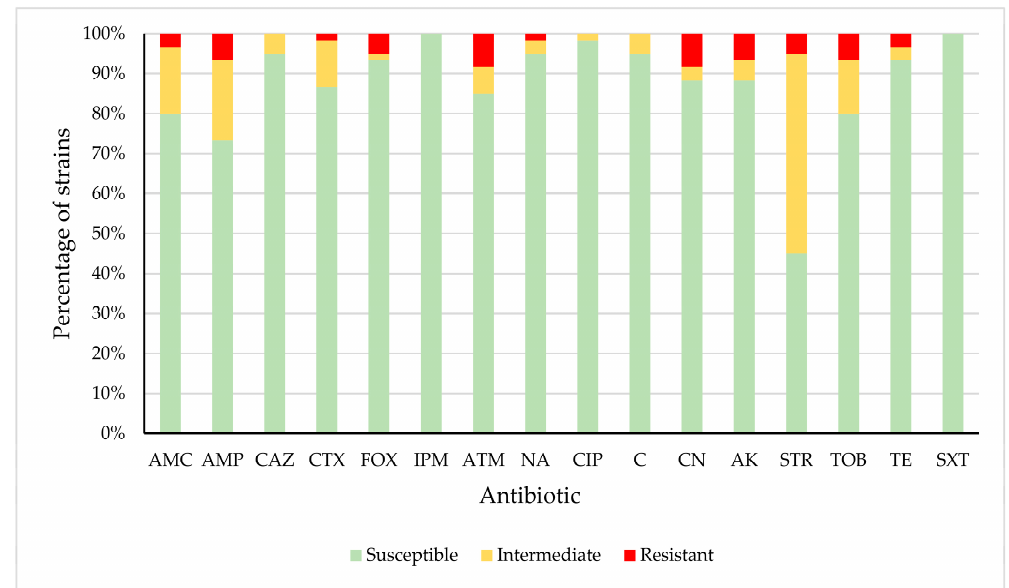
Figure 1. Percentage of Escherichia coli strains susceptible, intermediate or resistant to each antibiotic